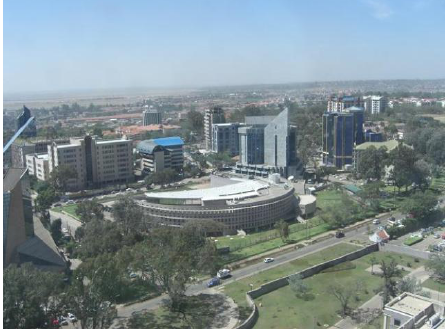
Figure 2. Panoramic View of Upper Hill Area